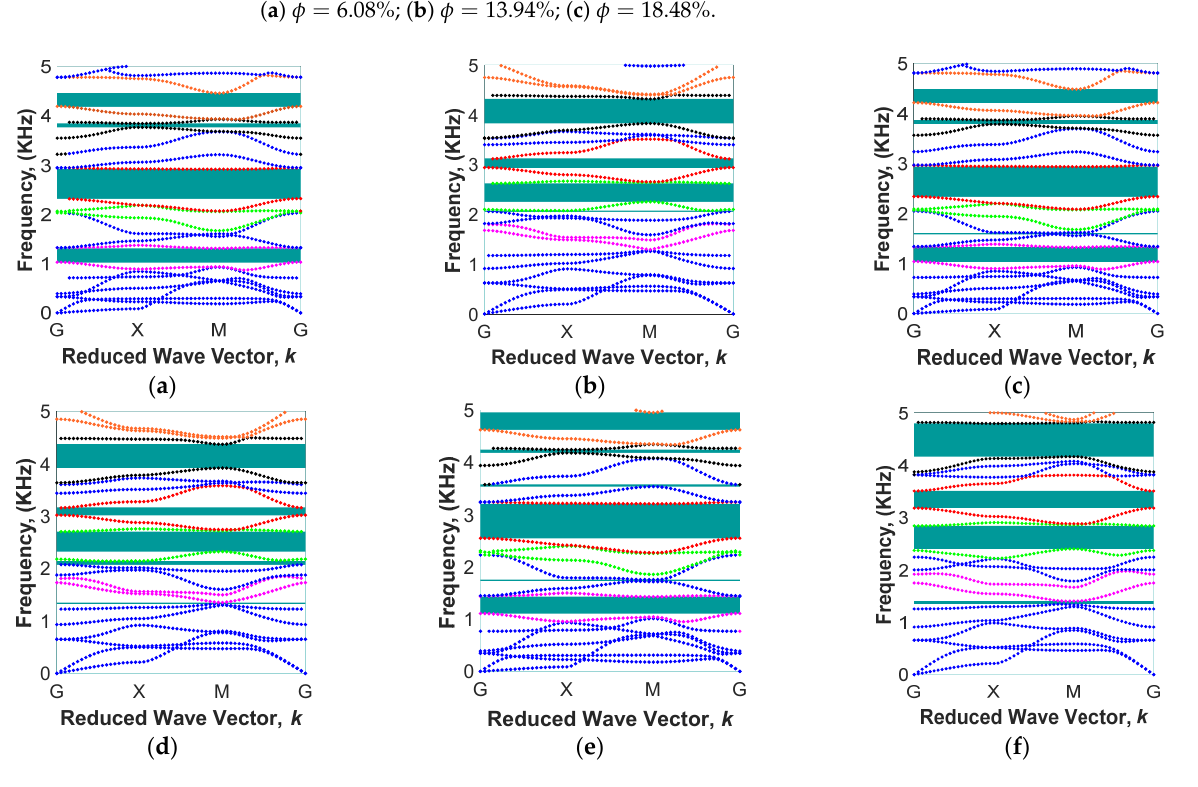
Figure 13. Active band structures in different magnetic fields in various volume fractions with the fixed cylindrical core radius of L / R = 8, and the fixed arm angle θ = − 1 ◦ : ( a ) φ = 6.08% & B = 75 mT; ( b ) φ = 6.08% & B = 225 mT; ( c ) φ = 13.94% & B = 75 mT; ( d ) φ = 13.94% & B = 225 mT; ( e ) φ = 18.48% & B = 75 mT; ( f ) φ = 18.48% and B = 225 mT (Seventh and eighth mode shapes colored in purple and represent the first band gap; Eleventh and twelfth mode shapes colored in green and represent the second band gap; thirteenth and fourteenth mode shapes colored in red and represent the third band gap; Seventeenth and eighteenth mode shapes colored in black and represent the fourth band gap; Nineteenth and twentieth mode shapes colored in orange and represent the fifth band gap).